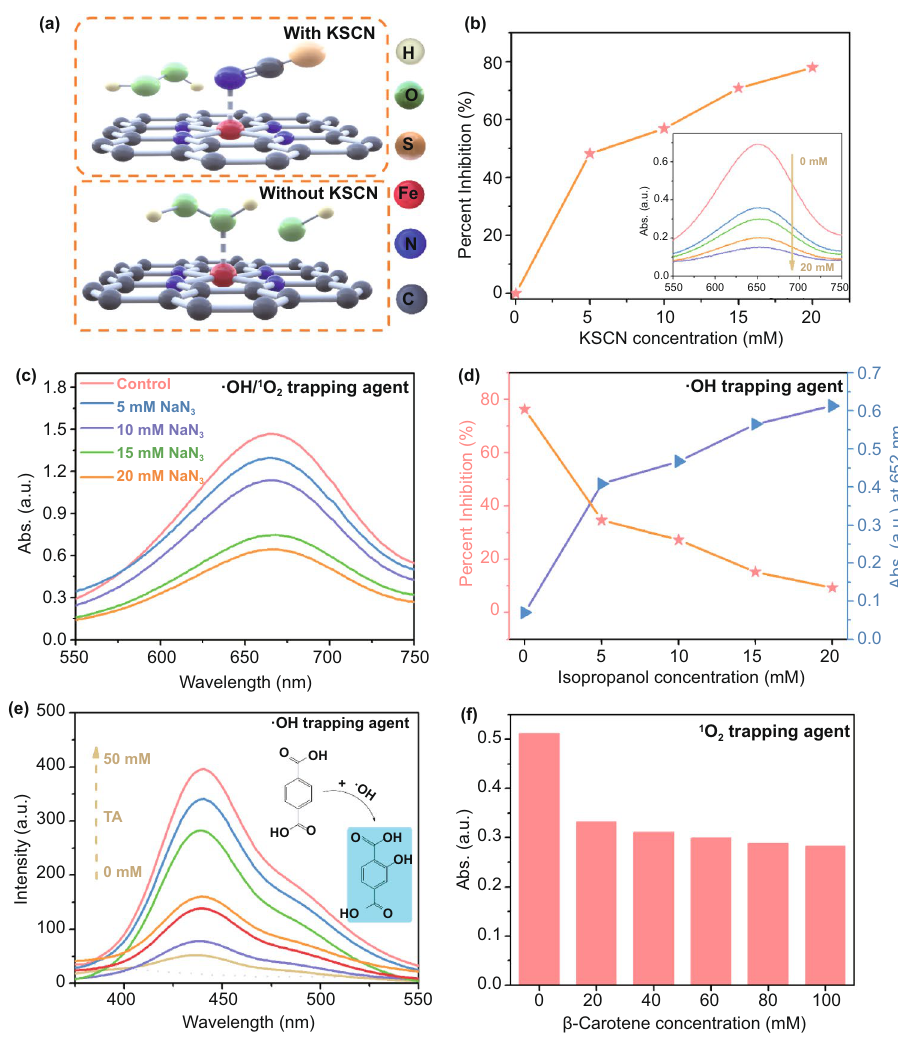
Fig. 4 a Schematic illustration of the mechanism of KSCN influence. b Percent inhibition and absorption change of IIM-Fe- SASC + TMB + H 2 O 2 solution upon the addition of various concentrations of KSCN. c Absorbance changes after adding various amounts of NaN 3 . d Percent inhibition and absorption change after adding isopropanol. e TA as a •OH fluorescent probe. f Absorption change after adding β-carotene with different